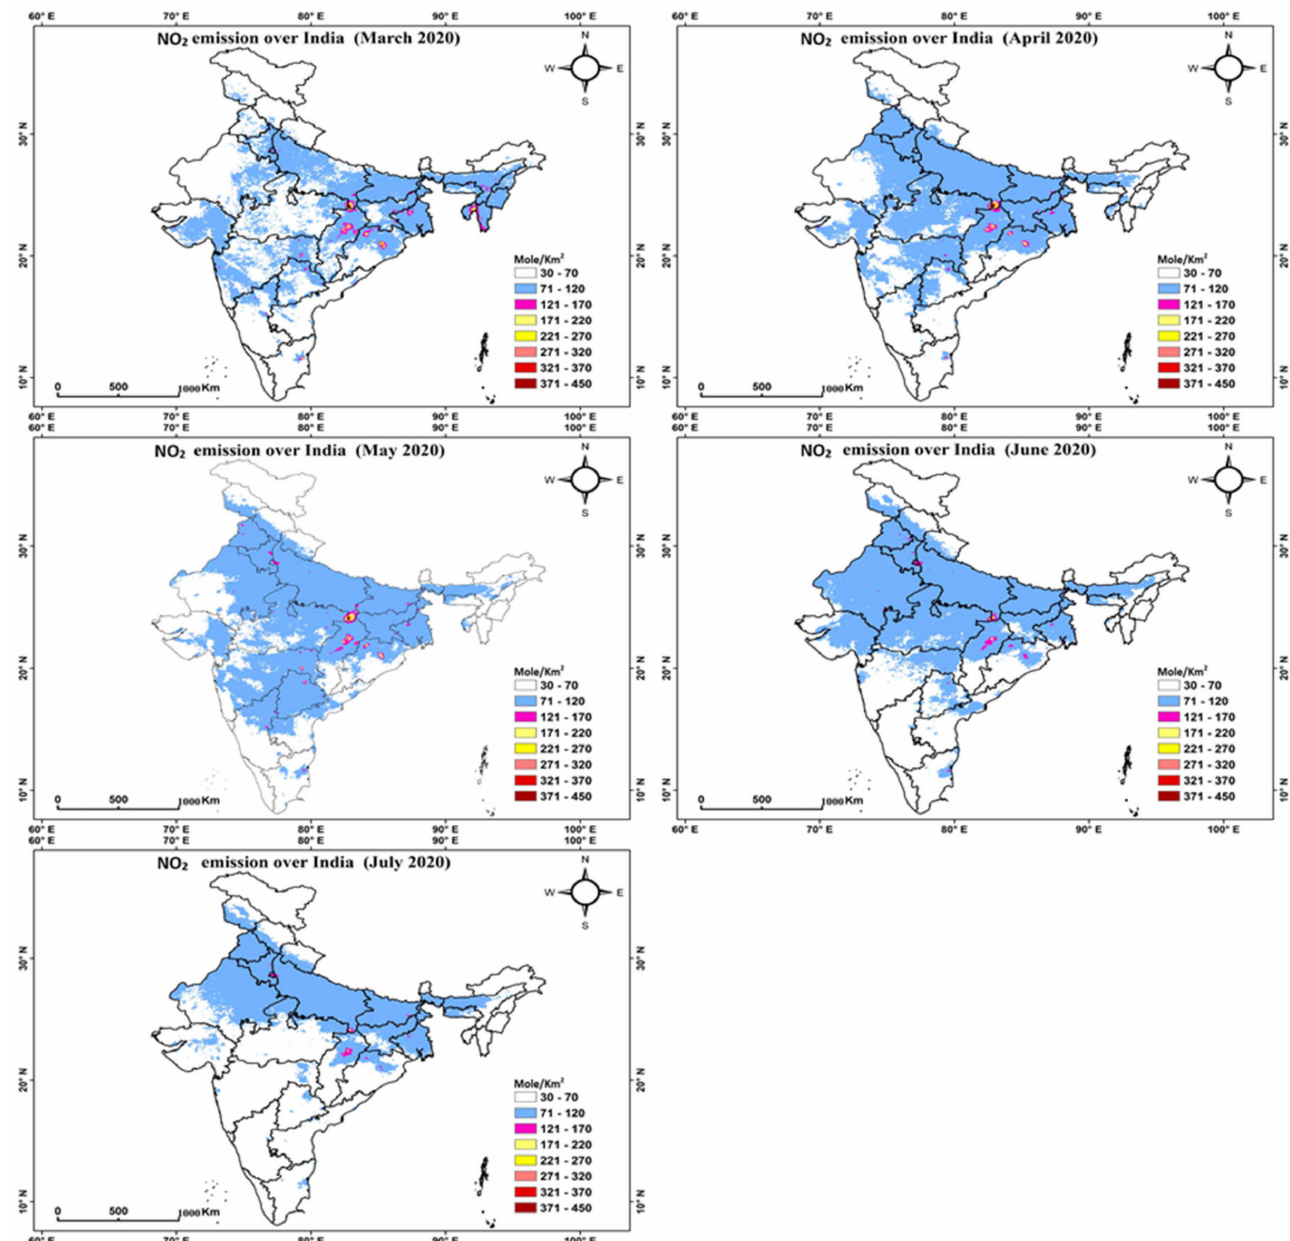
Figure 2. NO 2 emissions over India as observed by Sentinel-5P during lockdowns (phase 1–3) and unlocking periods (phase 1–2) from March to July